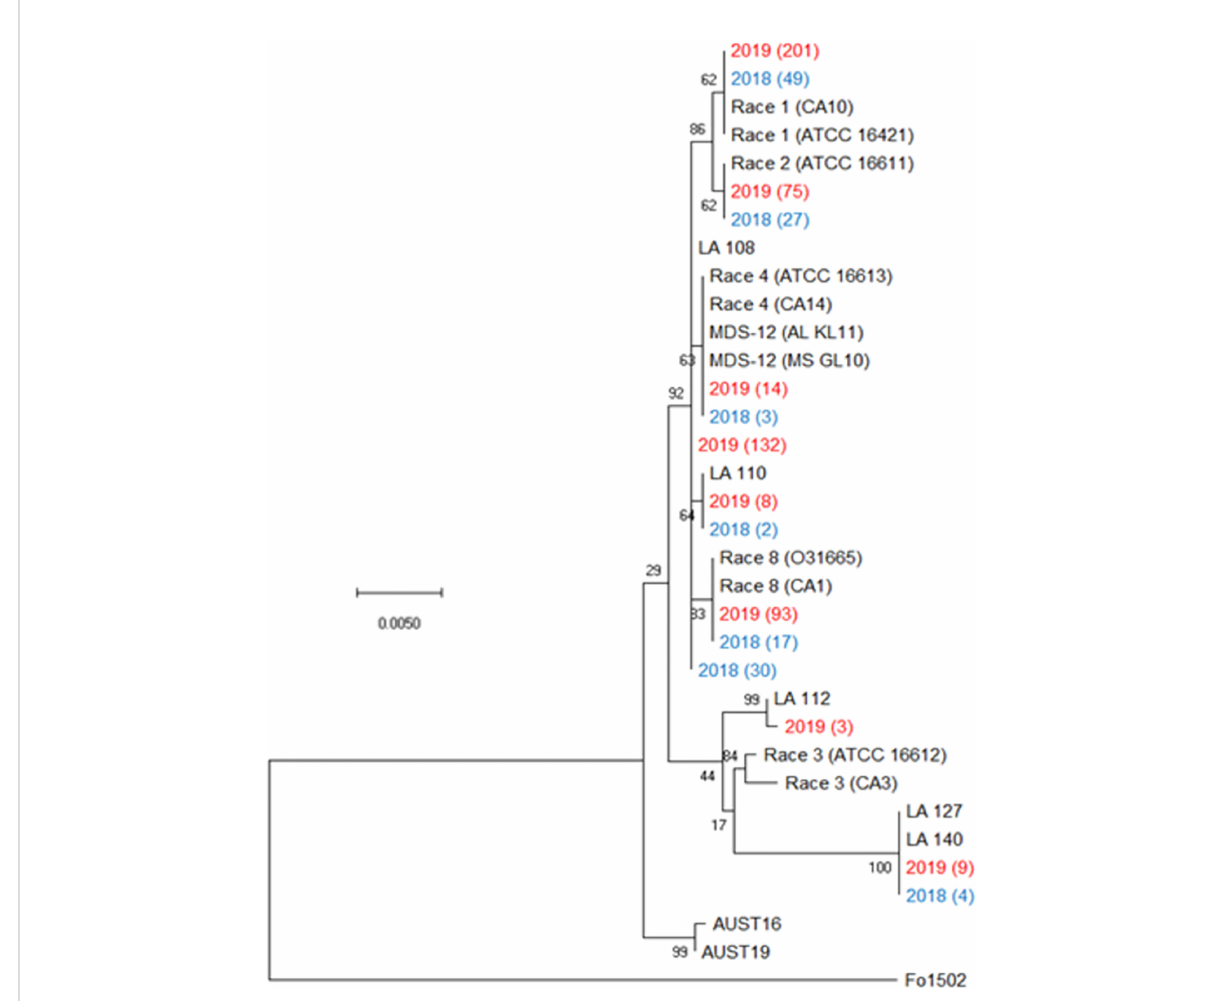
FIGURE 2 Condensed phylogenetic tree of FOV isolates collected during the 2018 and 2019 cotton seasons using a partial sequence analysis of the translation elongation factor, b -tubulin, and the phosphate permease genes. Tree was constructed in MEGAX using the maximum likelihood method based on the Tamura-Nei model (Tamura and Nei, 1993). The tree with the highest log likelihood (-2944.90) is shown. Bootstrap frequencies from 1,000 replications are noted next to every branch. Isolates with identical sequences collected during the study are represented by a single isolate in the tree and are labeled with the year of collection and the number of identical isolates that were found. For example, isolate 2019 (201) represents 201 identical isolates that were collected in 2019. Isolates collected during the 2018 season are shown in blue and isolates collected during 2019 are shown in red. References isolates (in black) used for comparison are labeled by the race followed by an isolate name, for example Race 1 (CA10) is a race 1 reference isolate identi fi ed as CA 10. A non-pathogenic Fusarium oxysporum (isolate 1502) was used as an outgroup to root the